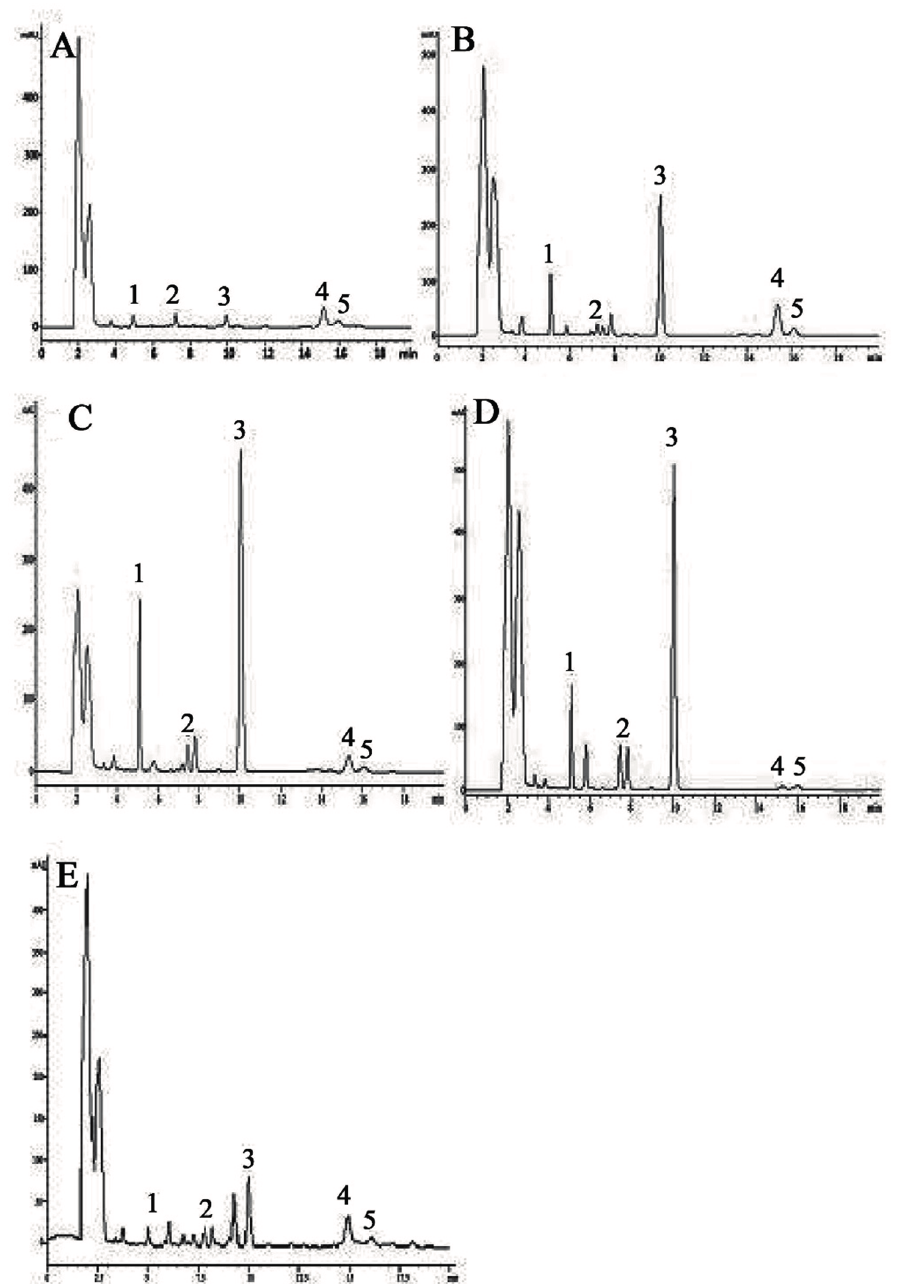
Figure 9. Representative HPLC chromatograms of different age S. campanulatum plants; ( A ) One year old; ( B ) Two years old; ( C ) Five years old; ( D ) Seven years old and ( E ) Ten years